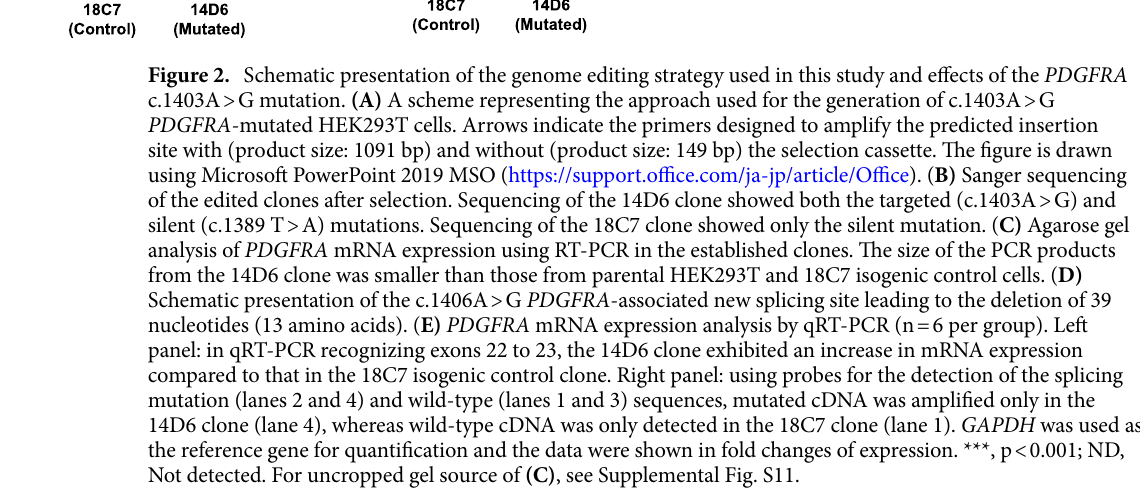
c. 1403A > G mutation. Figure 2A summarizes the genome editing strategy used. After co-transfection of the sgRNA4- and Cas9 nuclease-expressing vector and of the donor vector into HEK293T cells, mNeonGreen-